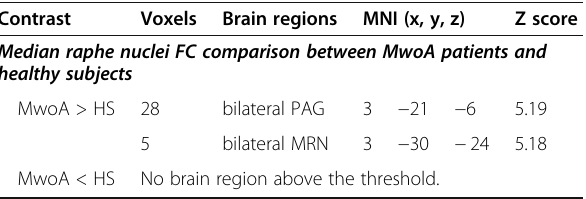
Table 3 Altered median raphe nuclei functional connectivity in MwoA patients Contrast Voxels Brain regions Median raphe nuclei FC comparison between MwoA patients and healthy